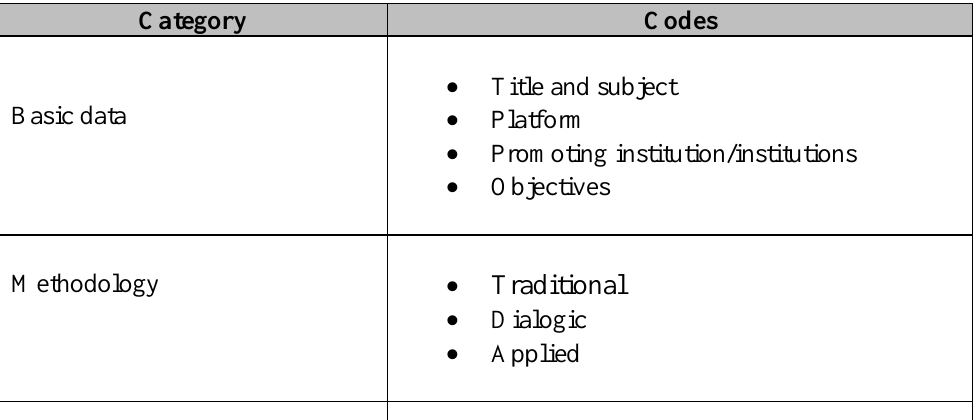
Research Categories and